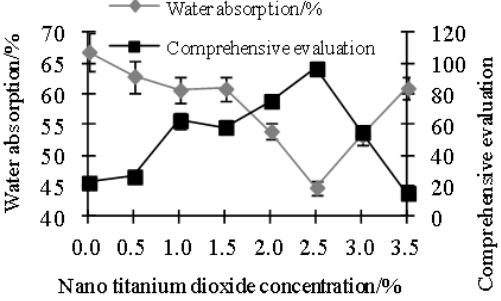
Figure 2. Effects of nano-TiO 2 concentration on water absorption and comprehensive evaluation.